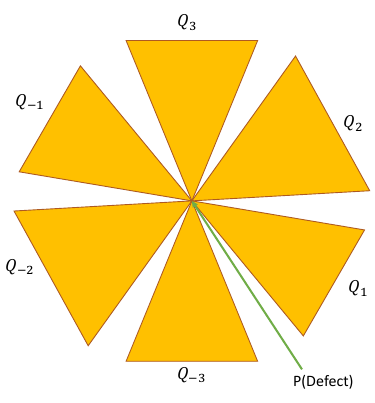
Figure 4 . Cartoon picture of the multiverse for n = 3 with de-Sitter metric on Karch-Randall branes. P is the ( d − 1) -dimensional defect and Karch-Randall branes are denoted by Q